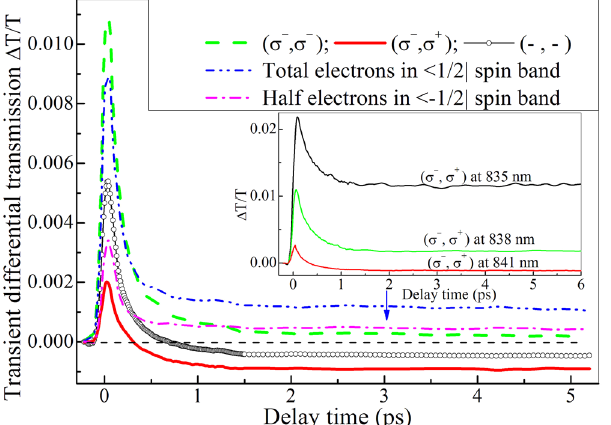
Figure 2. Transient differential transmissions for co-circularly ( σ − , σ − ) and cross-circularly ( σ − , σ + ) polarized as well as colinearly ( − , − ) polarized pump and probe pulses. They are measured at central wavelength of 841 nm with an excitation density of 8.4 * 10 9 cm − 2 . In inset transient differential transmission for cross- circularly polarized ( σ − , σ + ) pump and probe is plotted for femtosecond laser at three different central wavelengths of 841, 838 and 835